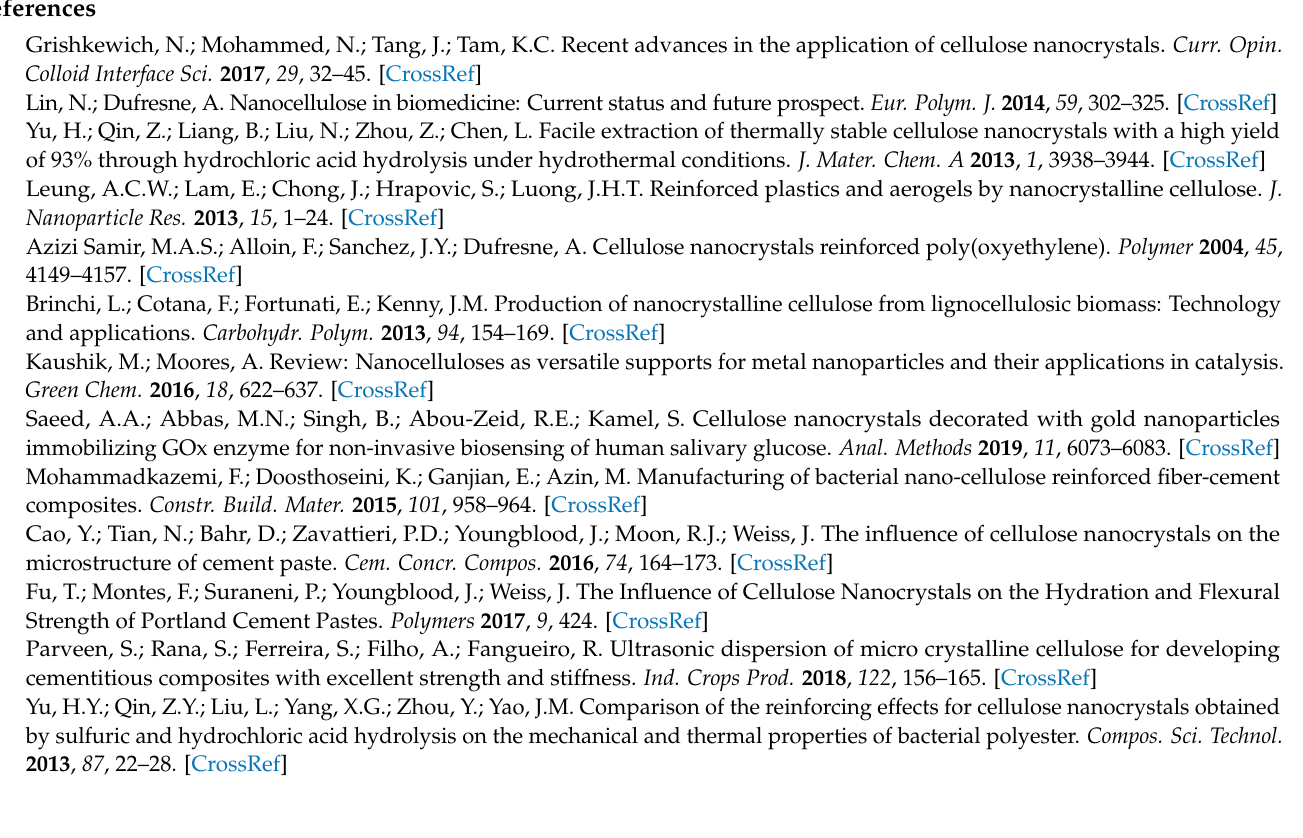
Table S1. DLS and yield results for CNC-H production; Table S2. DLS and yield results for CNC-S production; Table S3. Total sulfate groups of CNC-S; Table S4. AFM measurements of CNC-H; Table S5. AFM measurements of